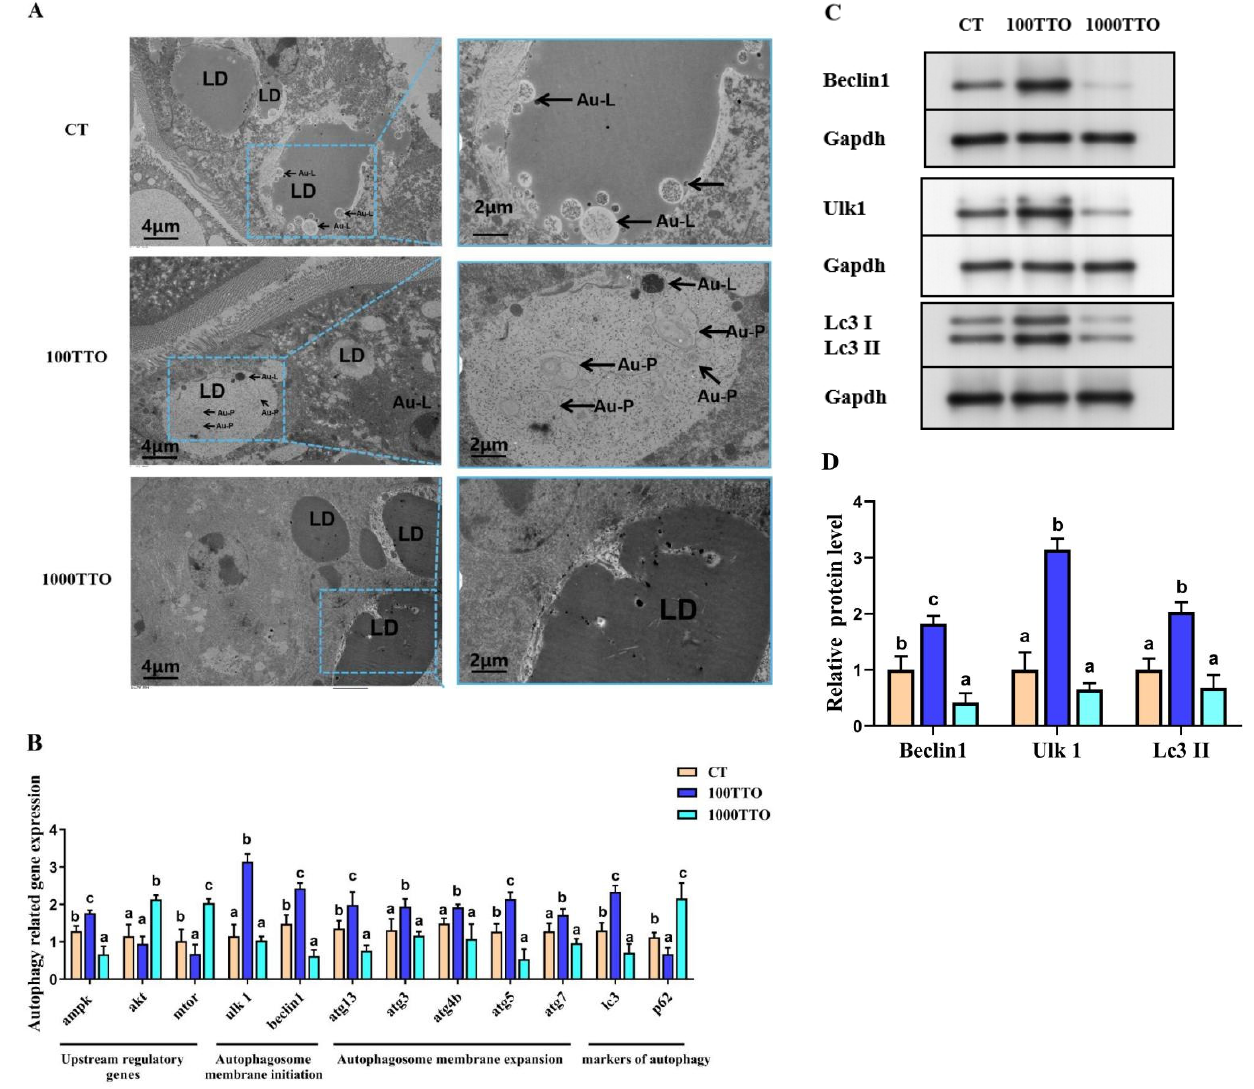
Figure 7. Effects of dietary TTO levels on autophagy formation in the hepatopancreas of M. rosenbergii . ( A ) Characteristic TEM image. Arrow points to autophagy. LD, lipid droplet; Au-P, autophagosome; Au-L, autolysosome. ( B ) mRNA levels of key autophagy-related genes. ( C ) Beclin1, Ulk1, and Lc3 protein bands under Western blot analysis. ( D ) Relative quantification of Beclin1, Ulk1, and Lc3 II protein expression. The significant difference between the three TTO levels is characterized by different lowercase letters (a, b, c) ( p <